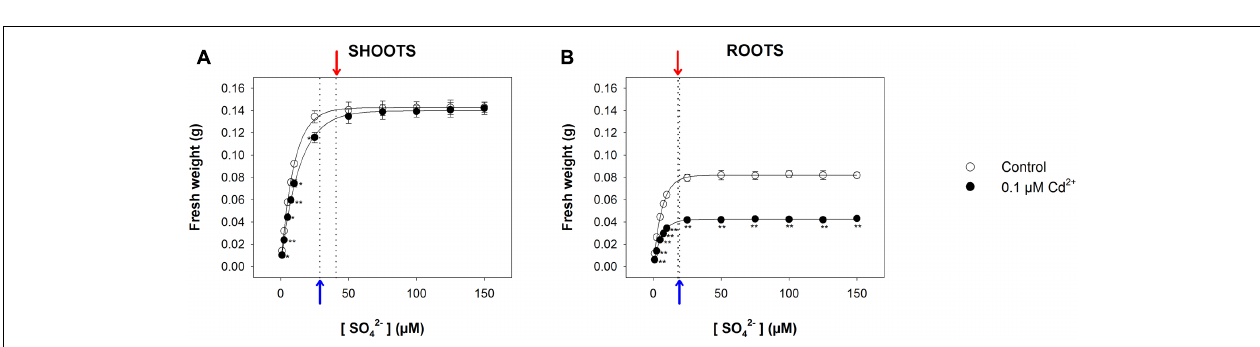
FIGURE 3 | Effect of short-term exposure to Cd on the sulfate uptake capacity of the roots. Arabidopsis plants were pre-grown for 19 days under four sulfate concentrations (5, 25, 50, and 150 µ M) and then exposed for 72 h to three concentrations of Cd 2 + (0.1, 1, and 10 µ M). (A) Sulfate uptake capacity was evaluated by measuring the rate of 35 SO 42 − absorption into roots of intact plants over a 15 min pulse. The incubation solutions contained 150 µ M SO 42 − . (B,C) Changes in the relative transcript levels of SULTR1; 1 and SULTR1; 2 in the roots. Bars and error bars are means and SE of two experiments run in triplicate ( n = 6). Different letters indicate significant differences ( P < 0.05).